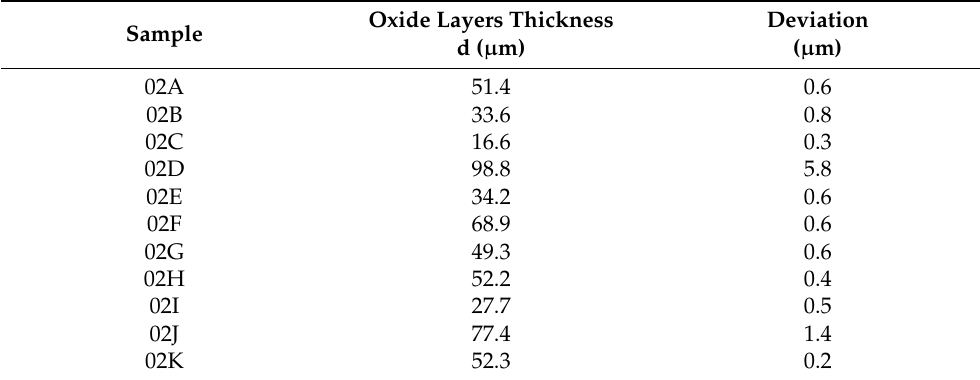
Table 4. List of thickness of Al 2 O 3 layers produced in anodizing process according to Hartley’s plan (after thermo-chemical treatment).